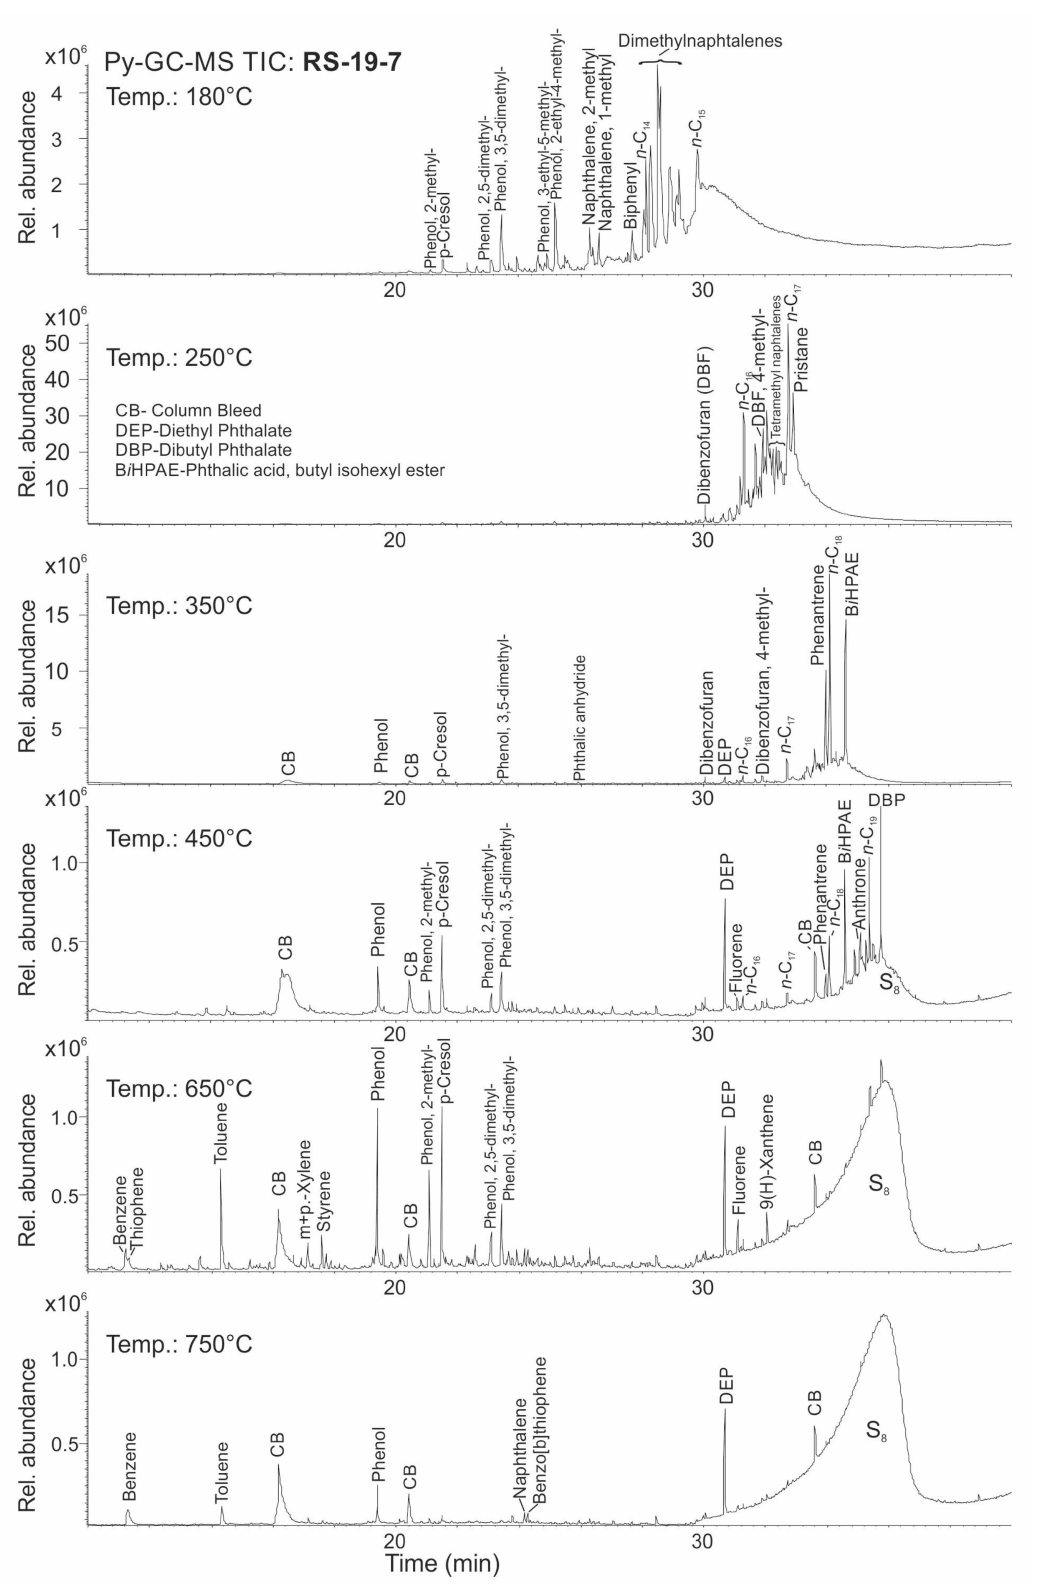
Figure 3. The total ion chromatograms (TIC) of pyrolysates of the RS-19-7 sample. Rel., relative; Temp.,